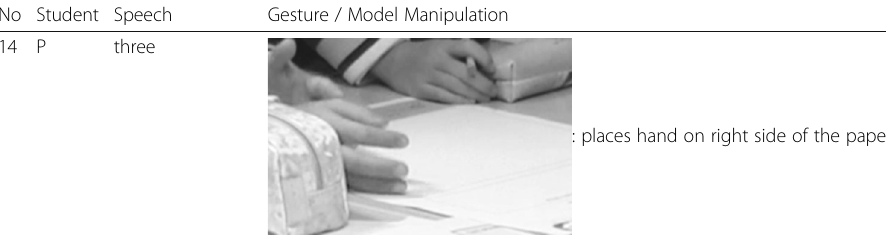
Table 4 Group 2 Co-Constructing the Drawing